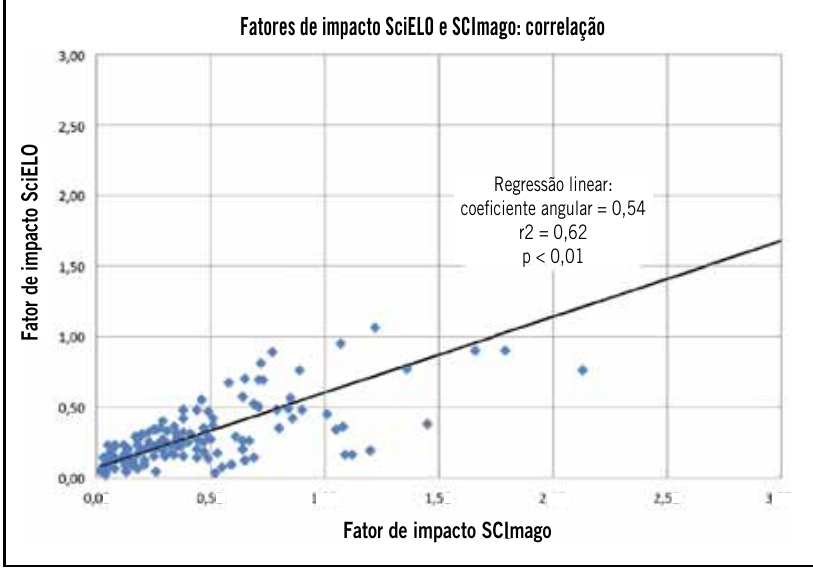
Figura 3 – Correlação entre fatores do impacto SciELO e SCImago (2009) para 142 periódicos brasileiros representados nos dois índices com valor > 0. O coeficiente angular indica angulo de 28o e impacto SciELO médio 40% menor que